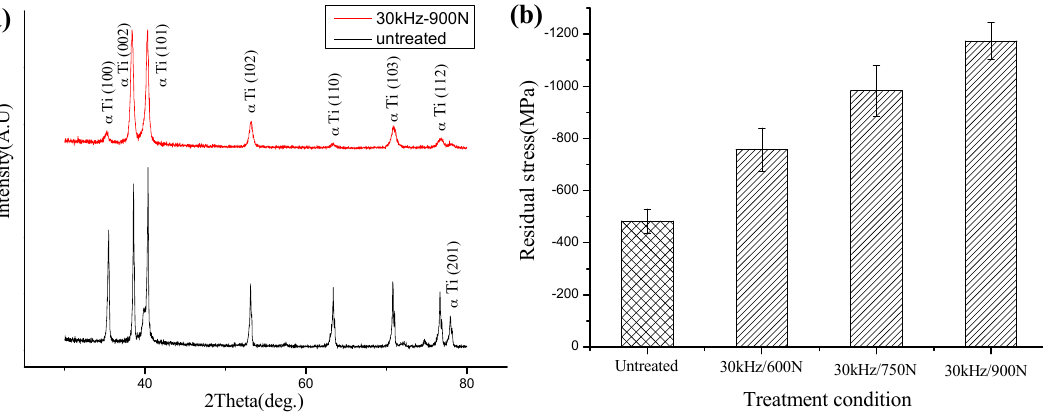
Figure 6. X-ray diffraction analysis: ( a ) X-ray spectra of the MUSR-treated sample at 900 N and the untreated sample; ( b ) compressive residual stress for the MUSR-treated sample at different loads and the untreated sample.